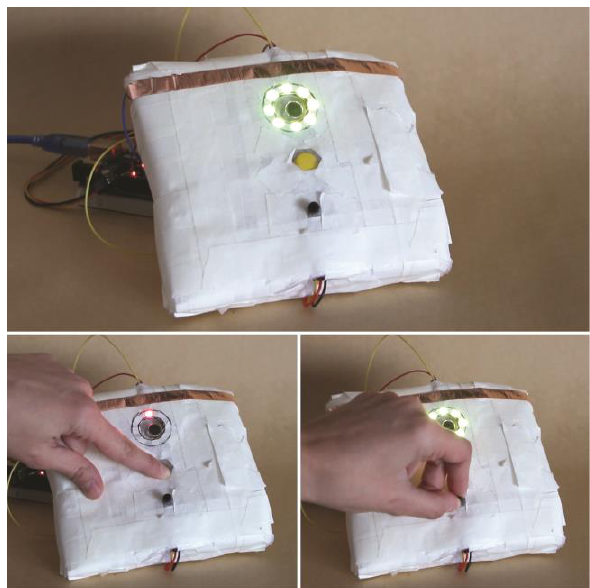
Figure 8 | Low-functioning and low-fidelity prototype. It allows to record a sound by pushing the button and to select a colour by turning the potentiometer. The touch-conductive copper band, placed on top, allows to save the training after